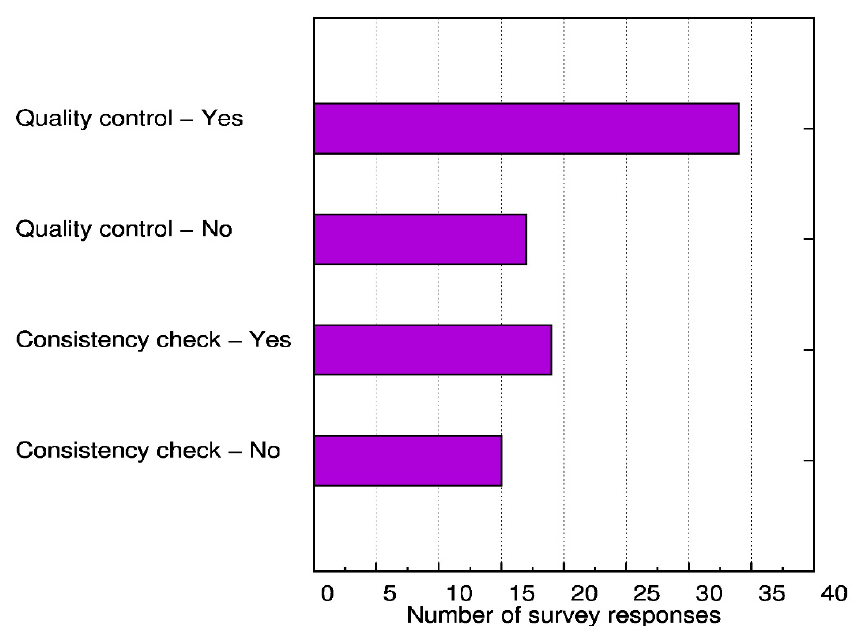
Figure 7. Quality control and consistency check of snow observations or products.